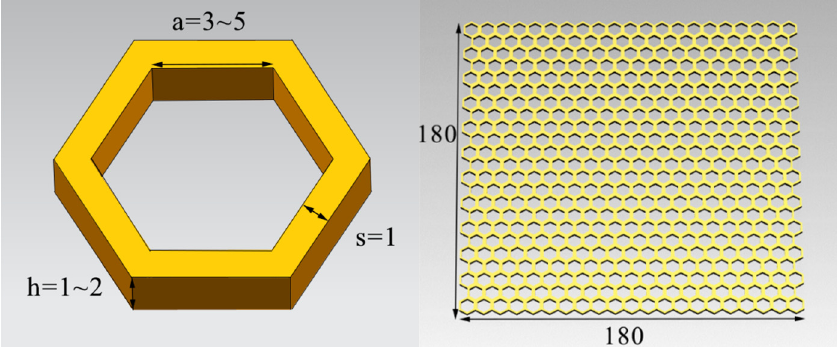
Figure 10. Parameters of the honeycomb structure (unit: mm).